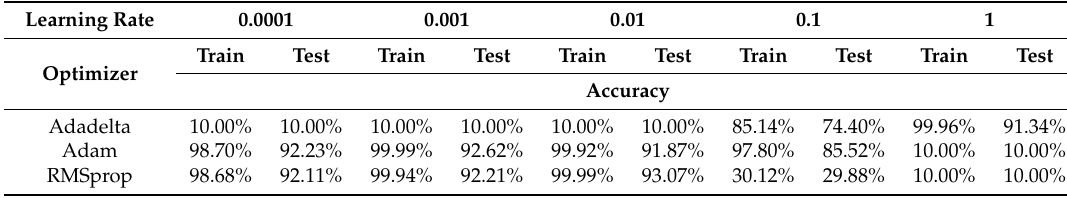
Table 3. Experiments of different optimizers and learning